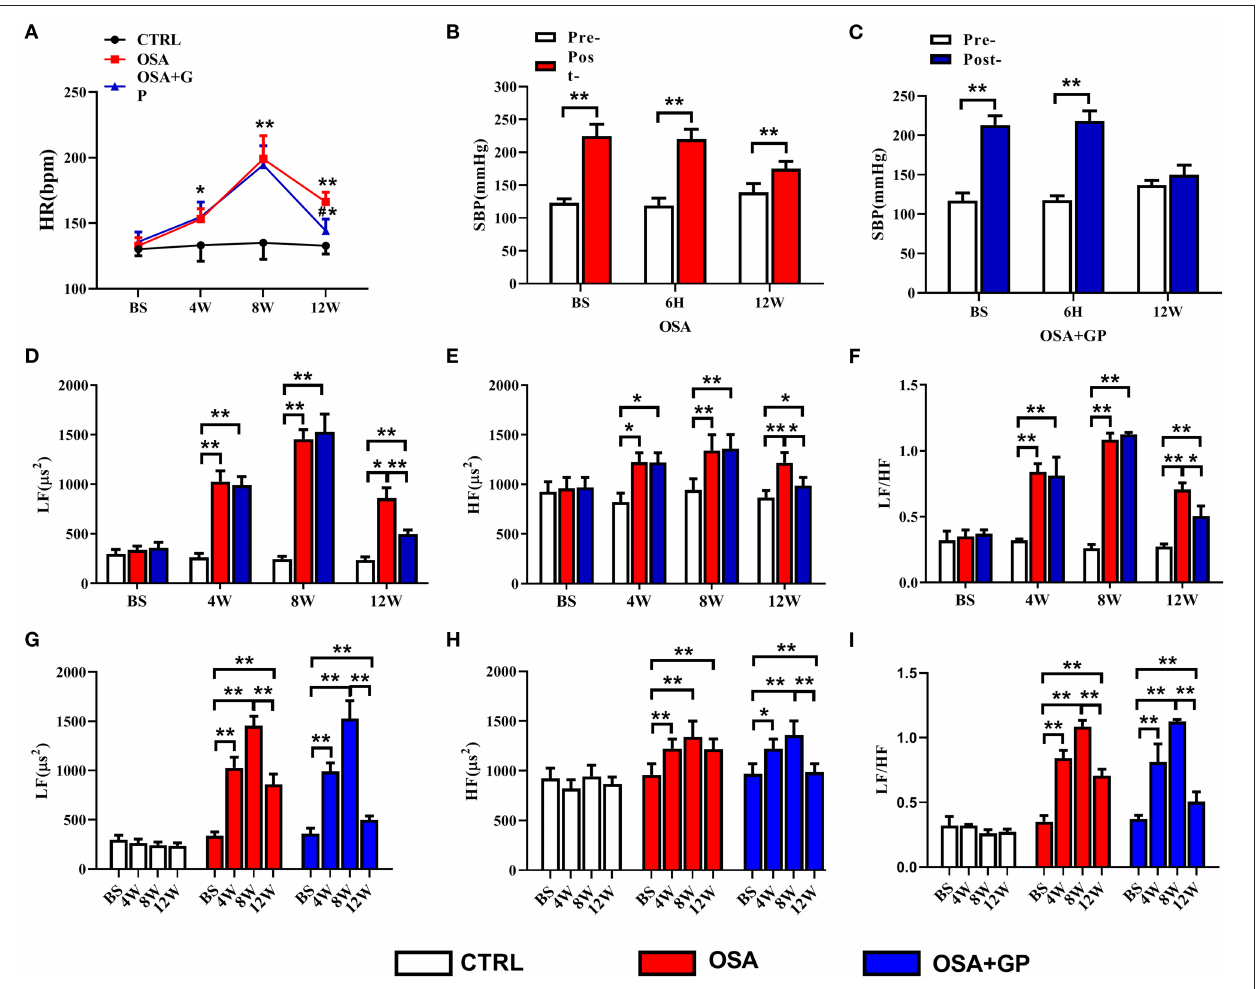
FIGURE 7 | Effect of SLGP ablation on the HRV. (A) Changes in HR among the three groups, * P < 0.05 vs. CTRL, ** P < 0.01 vs. CTRL, # P < 0.05 vs. OSA. Changes in SBP in the OSA group (B) and the OSA + GP group (C) at baseline, 6h, and the 12th week, ** P < 0.01 vs. Pre-. Change in LF (D) , HF (E) , and LF/HF (F) among the three groups at baseline and the 4th, 8th, and 12th week, * P < 0.05, ** P < 0.01. Change in LF (G) , HF (H) , and LF/HF (I) in each group at baseline and the 4th, 8th, and 12th week; * P < 0.05,** P < 0.01. HR, heart rate; SBP, systolic blood pressure; LF, low frequency; HF, high frequency; LF/HF, the ratio between LF and HF; other abbreviations as in Figure 1